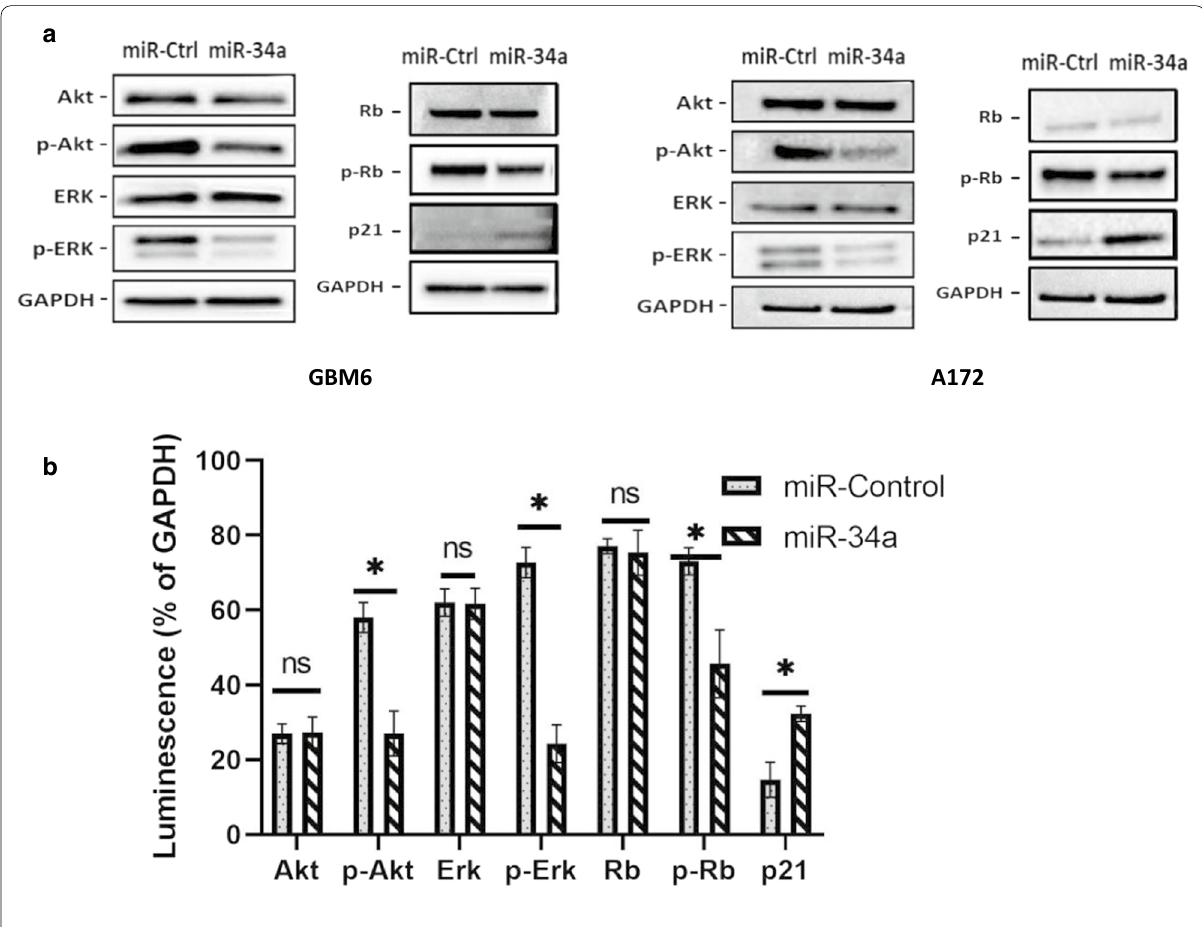
Fig. 1 Overexpression of miR-34a decreases oncogenic signaling in glioblastoma cells. a Representative western blot images showing reduction in phosphorylated Akt, ERK and Rb and increased p21 expression in miR-34a-transfected relative to control miRNA-transfected GBM6 and A172 glioblastoma cells. Cell lysates were prepared 2 days post-transfection and analyzed by western blotting. b Western blot data quantification (% reduction in luminescence relative to GAPDH) in the A172 cell line . Histograms showing means ( independent experiments, normalized to that of GAPDH. A paired t-test was used to test for significant difference between mean luminescence values. *p <